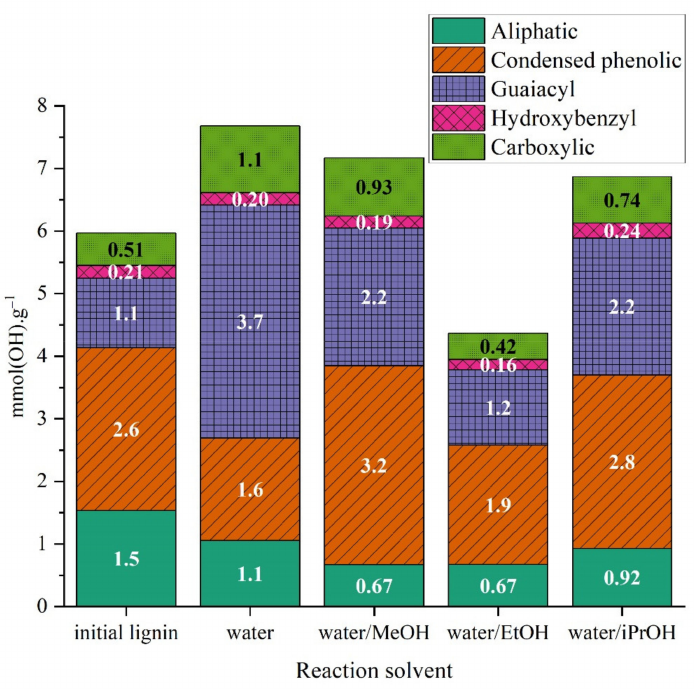
Figure 15. Concentration of OH groups in organic phases obtained in different solvent mixtures in the absence of